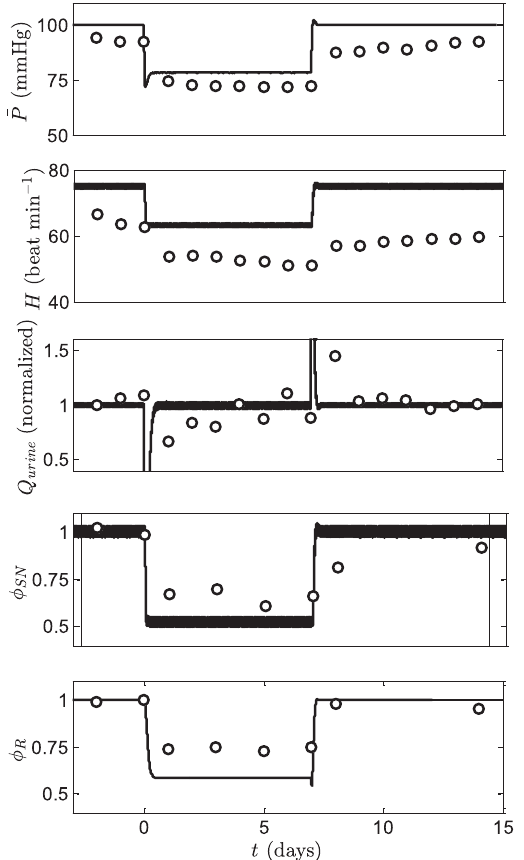
Figure 9. Response to chronic baroreflex stimulation. Electrical stimulation of the carotid baroreflex afferent nerve is simulated by modifying the normal model by replacing Equation (18) in the normal model with Equation (23) during the baroreflex stimulation period (for a 1-week period starting on day 0). Data on mean pressure, heart rate, urine output, plasma norepinephrine (plotted as φ ), and plasma renin activity (plotted as φ ) are obtained from SN RA Lohmeier et al. 23,24